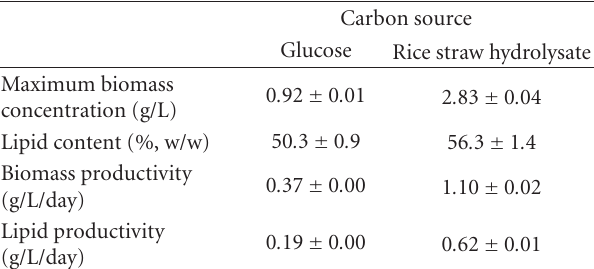
Table 1: The e ff ects of di ff erent carbon sources on cell growth and lipid accumulation of C hlorella pyrenoidosa .